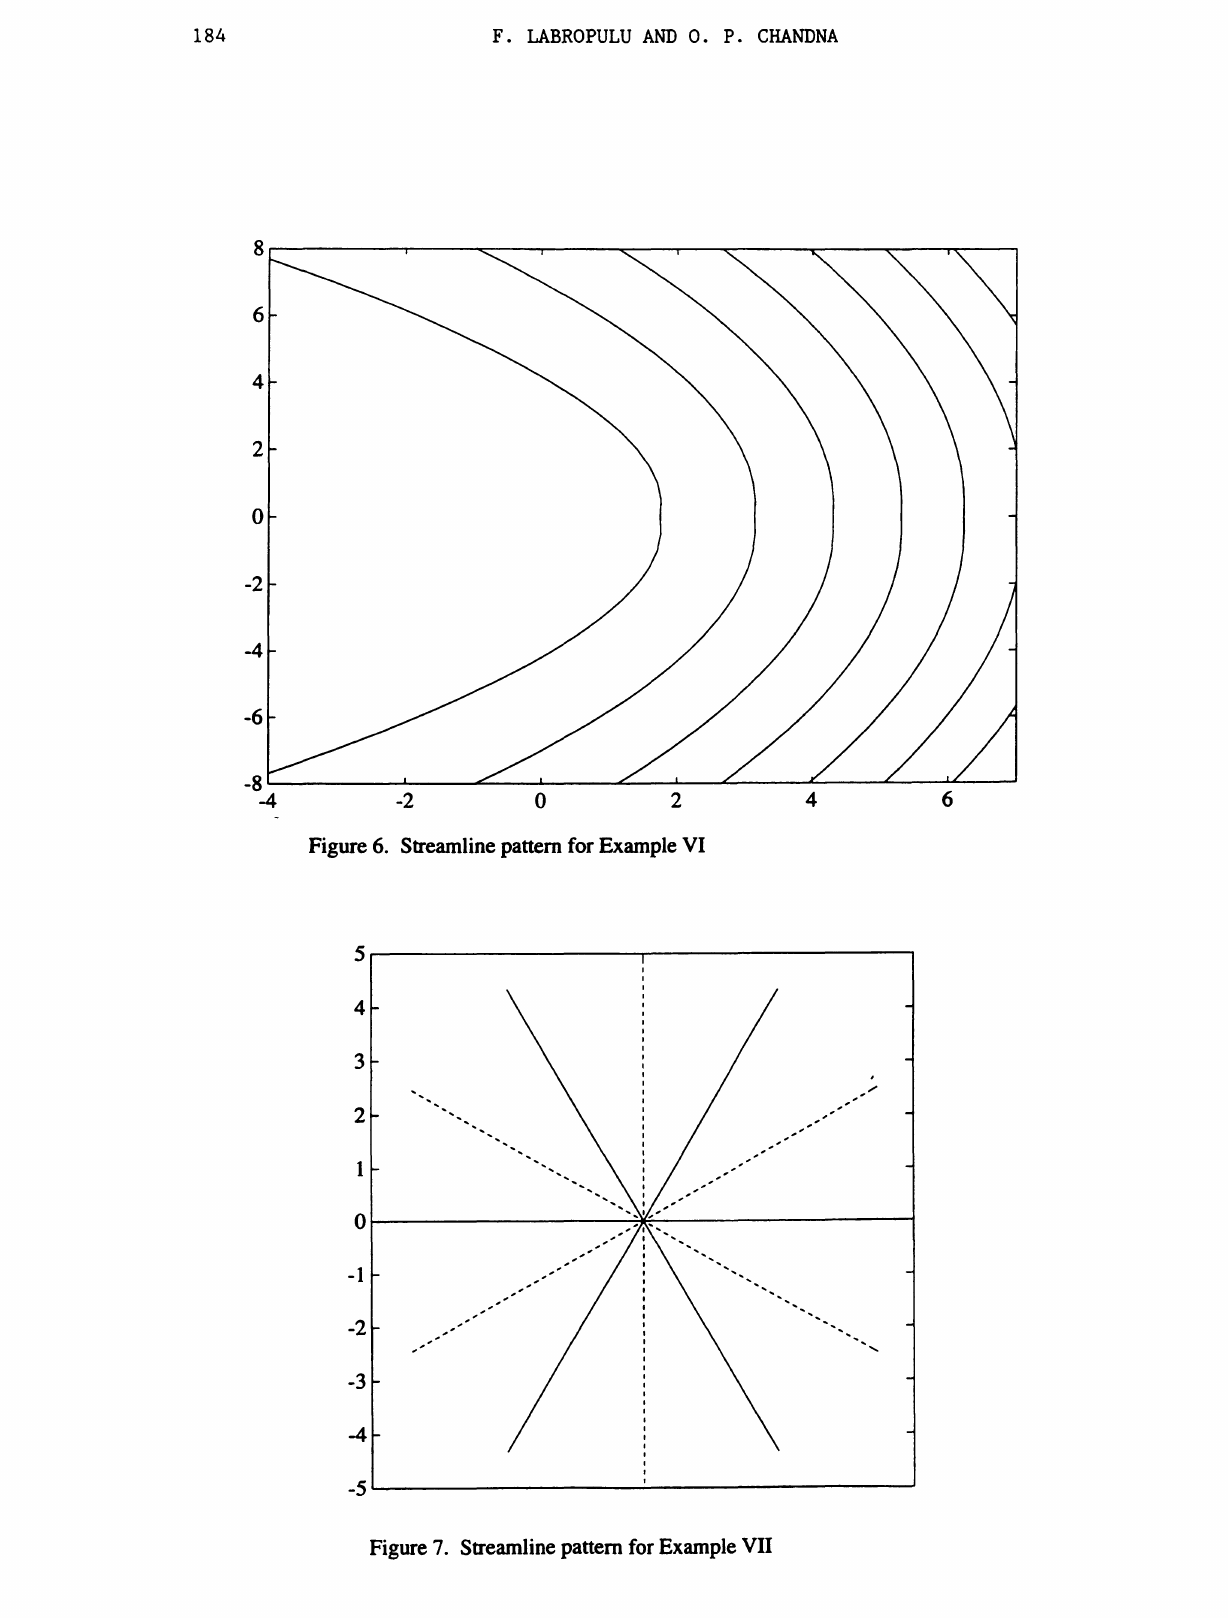
Figure 7. Streamline pattern for Example